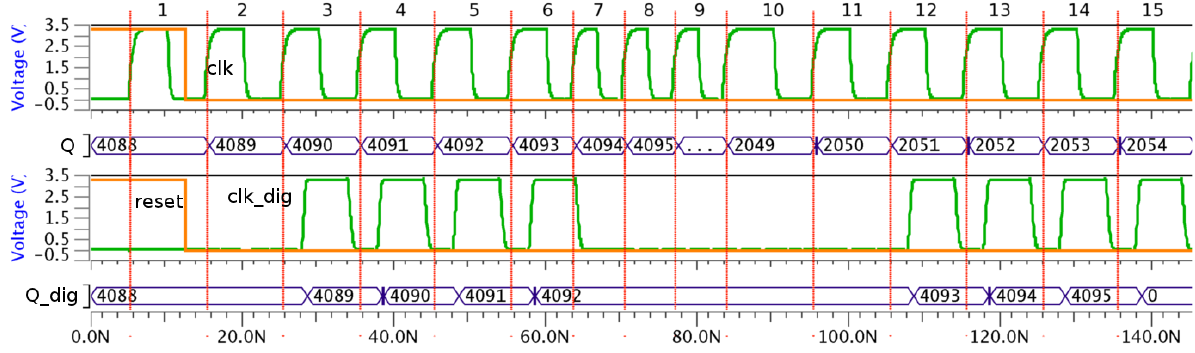
Figure 14. Behavior of an attacked accumulator without and with the proposed VLSI